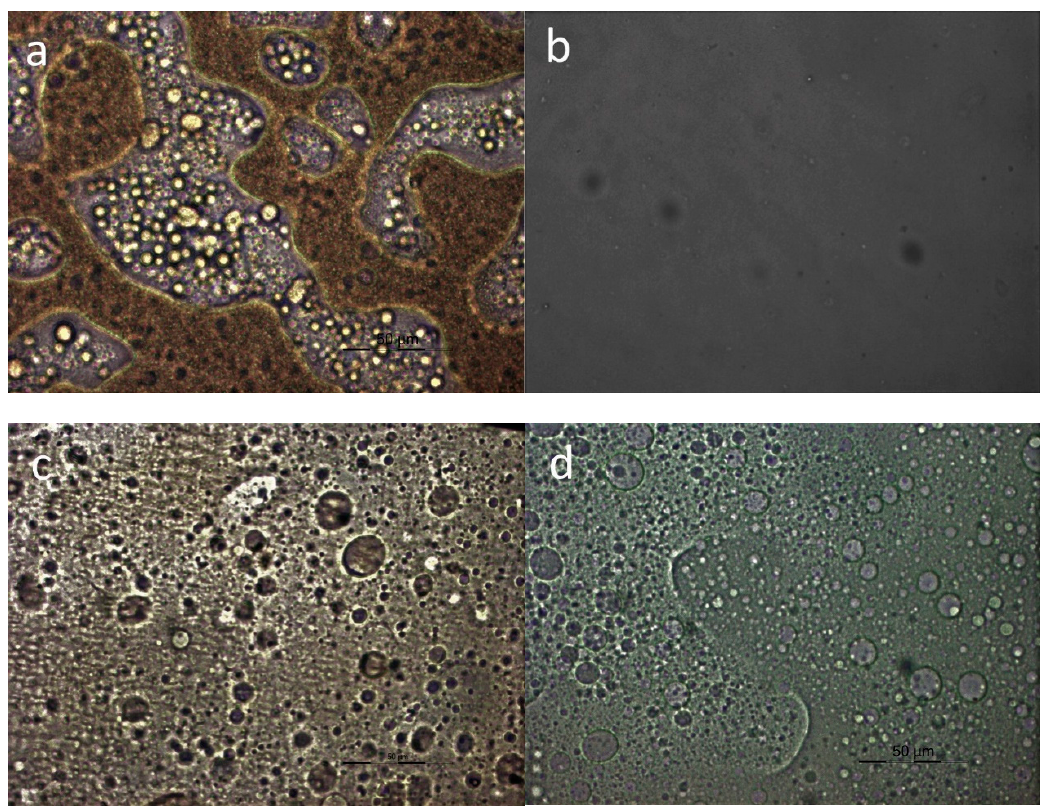
Figure 8. Polarized light microscopy (PLM) photographs for PBF blends in the melt phase: ( a ) PLA–PBF 50/50; ( b ) PET–PBF 50/50; ( c ) PPT–PBF 50/50; ( d ) PC–PBF 50/50.